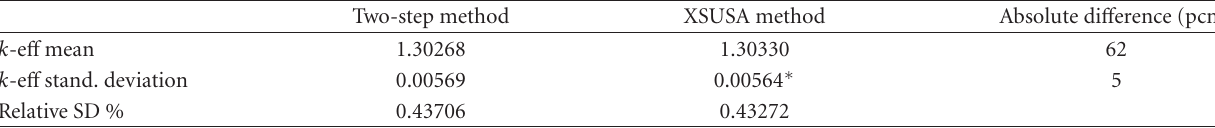
Table 2: Uncertainty in the e ff ective multiplication factor from using the two-step and XSUSA methods with a sample size of 290.